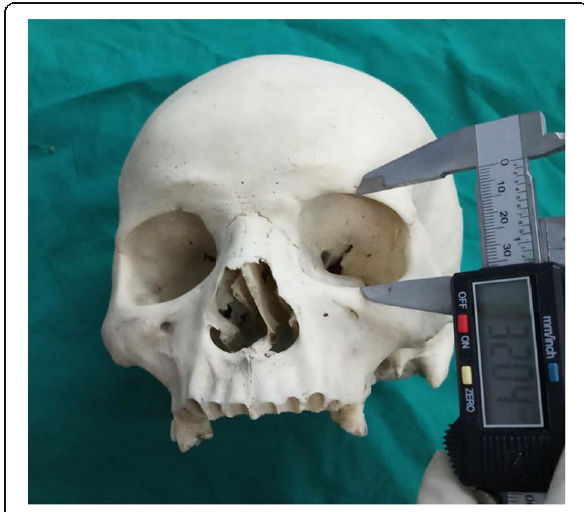
Fig. 3 The measurement of orbit height (OH): the direct distance between the superior and inferior orbital margins perpendicular to the orbital